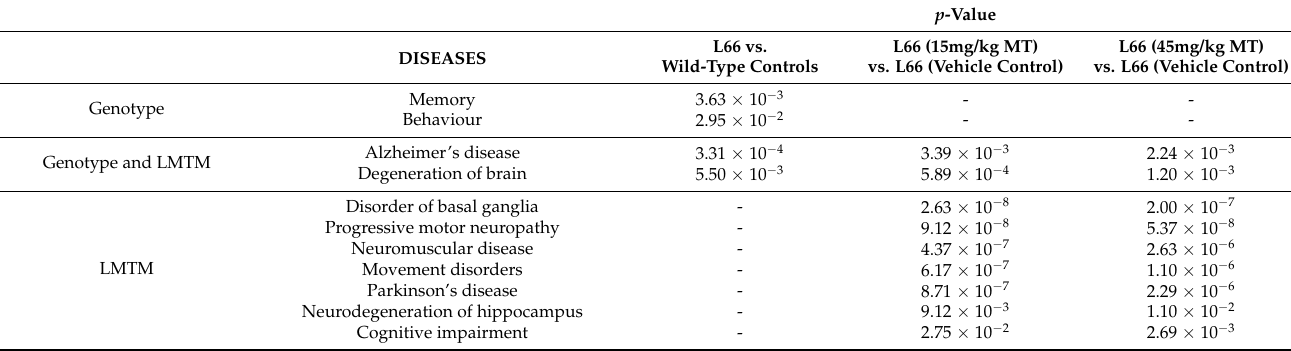
Table 3. Summary of significant hits for related diseases identified using IPA Core Analysis. The disorders are significantly altered due to tau overexpression, to LMTM treatment or both. Significant alterations were found by linking our proteomics data with the Ingenuity Knowledge Base. The diseases linked to protein changes are named and corresponding p -values are given.